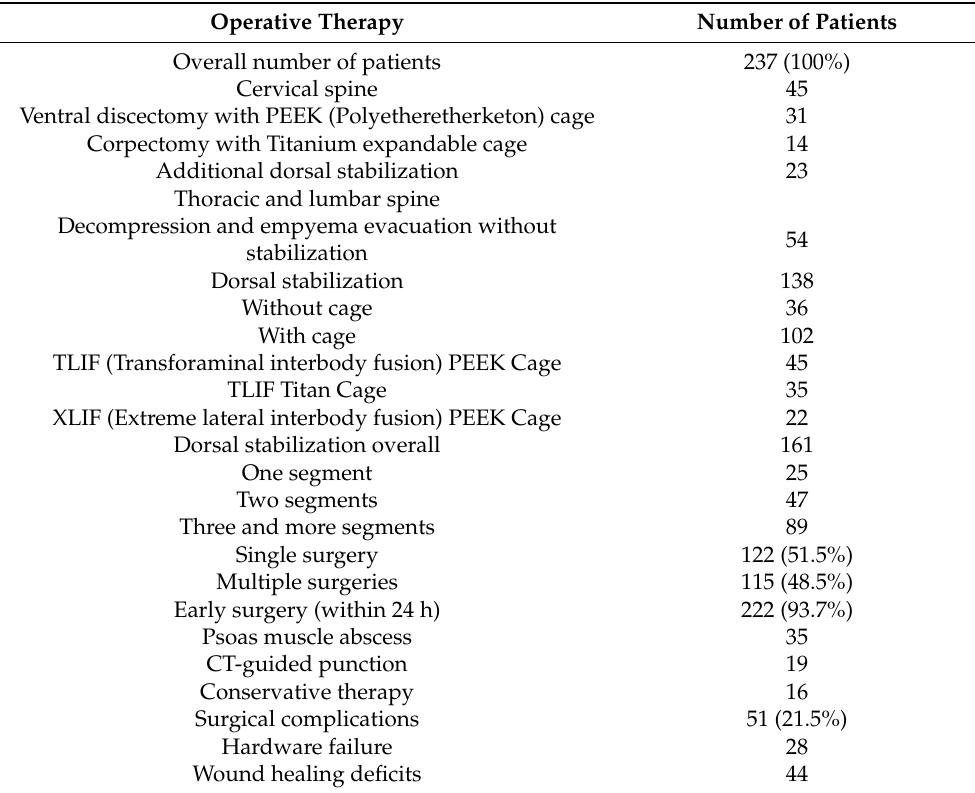
Table 4. Operative